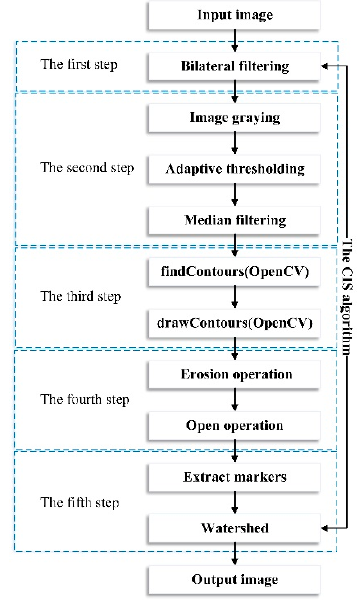
Figure 5. Block diagram of the coarse image segmentation (CIS) algorithm.